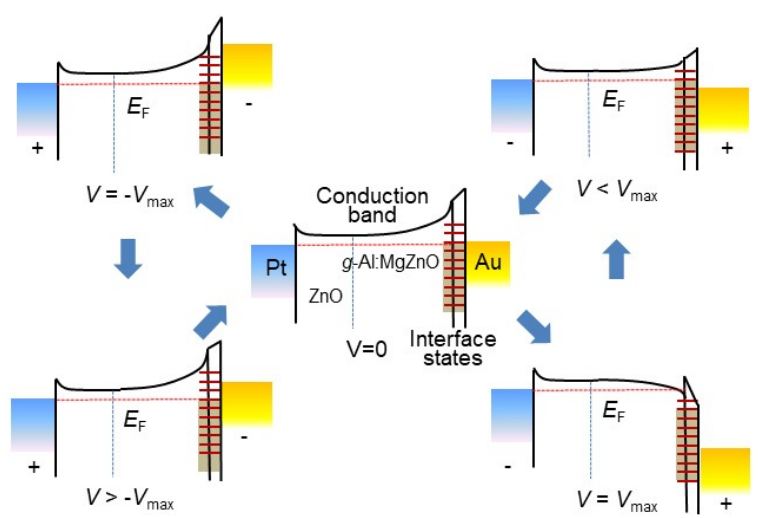
Figure 5. Schematics of charge trapping/detrapping at interface states during the bias voltage sweep (0 V → V max → – V max → 0 V) and modified Schottky barriers by Fermi level pinning. Interface localized states are indicated in short red lines at the interface and those in the shadowed region are filled states.